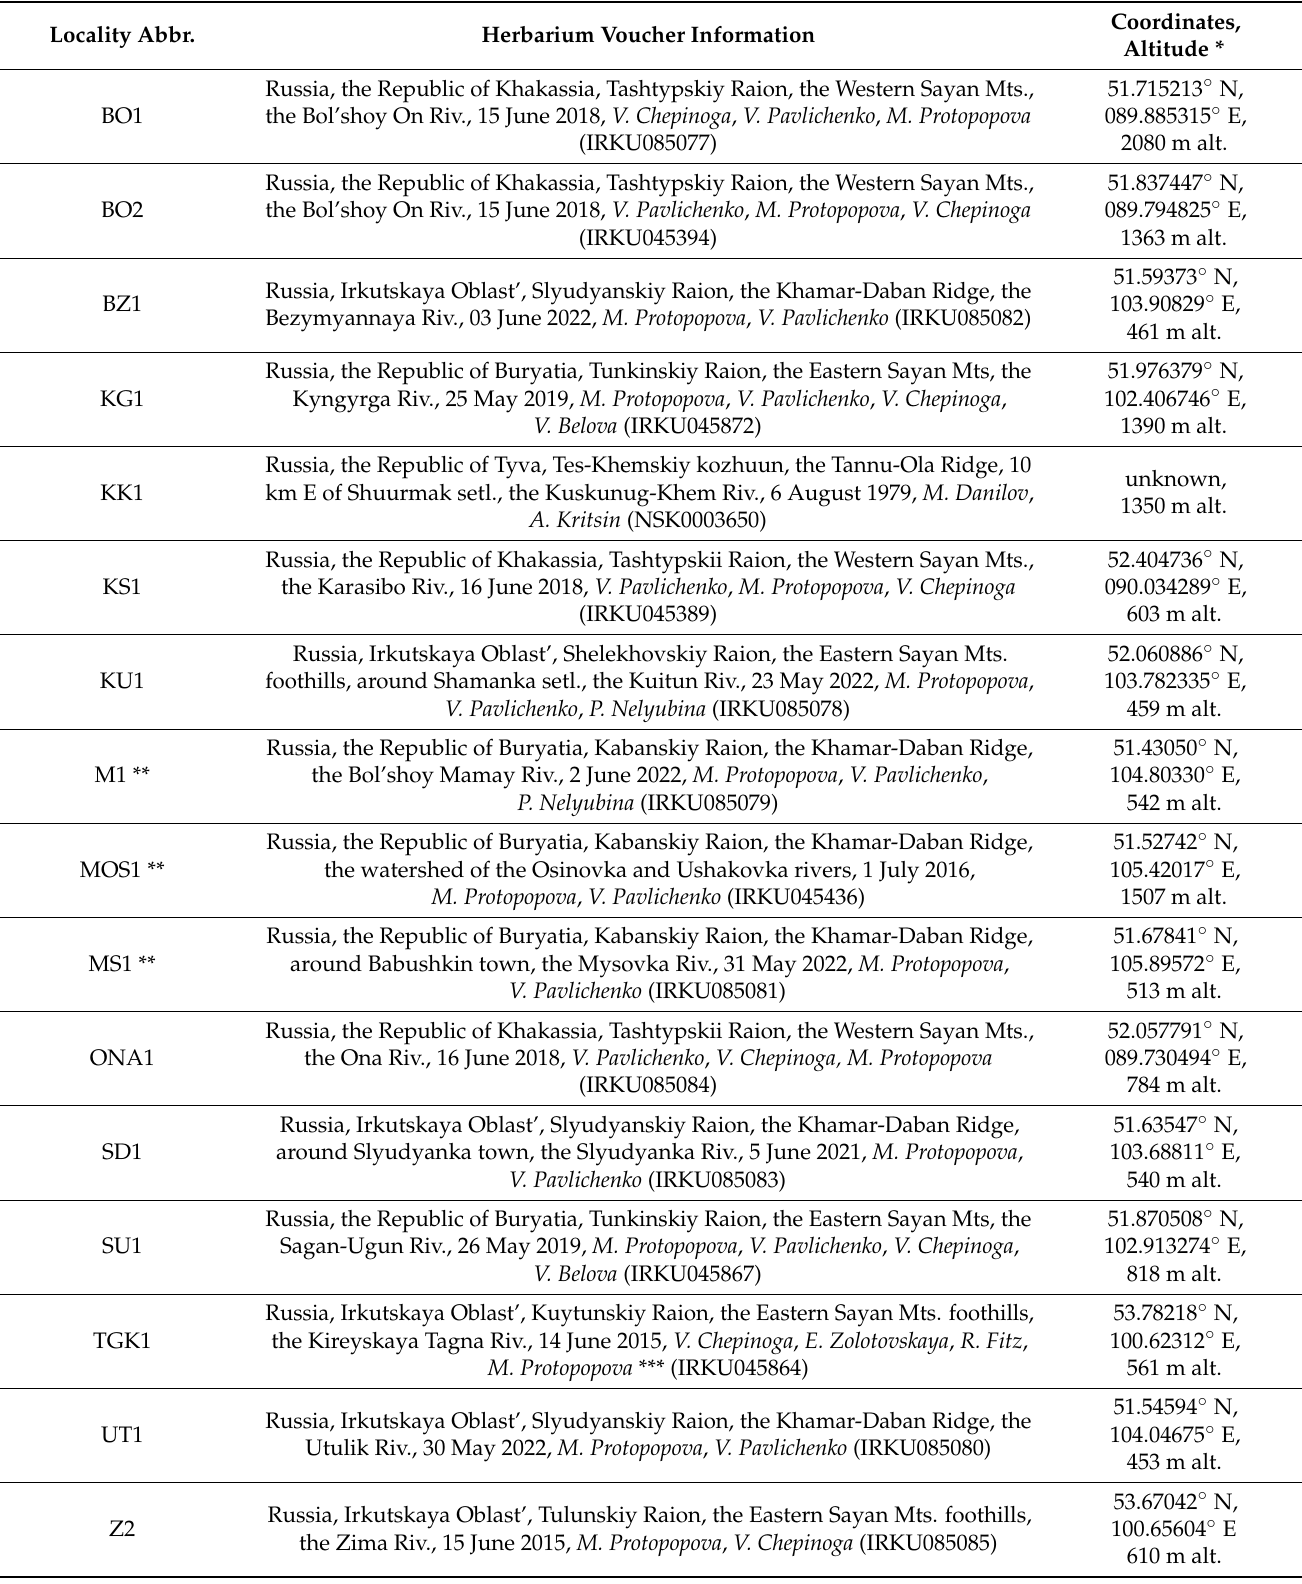
Table 1. The list of Eranthis sampling for DNA analysis. Locality